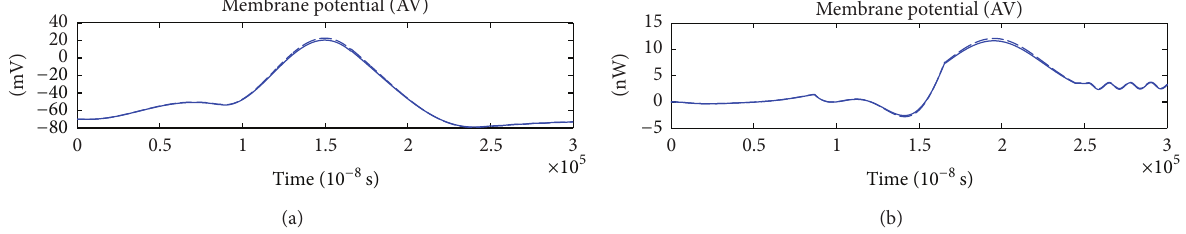
Figure 7: The action potential and its corresponding energy function. 𝑟 0𝑚 = 0.0001 Ω , 𝑟 1𝑚 = 0.1Ω , 𝑟 2𝑚 = 1000 Ω , 𝑟 3𝑚 = 0.1 Ω , 𝑟 𝑚 = 1000 Ω , = 1 𝜇 F, 𝐿 = 50 𝜇 H, 𝑖 = 70.7 𝜇 A, and 𝑄 = 1 × 10 −6 𝜇 𝐶 𝑚 𝑚 0𝑚